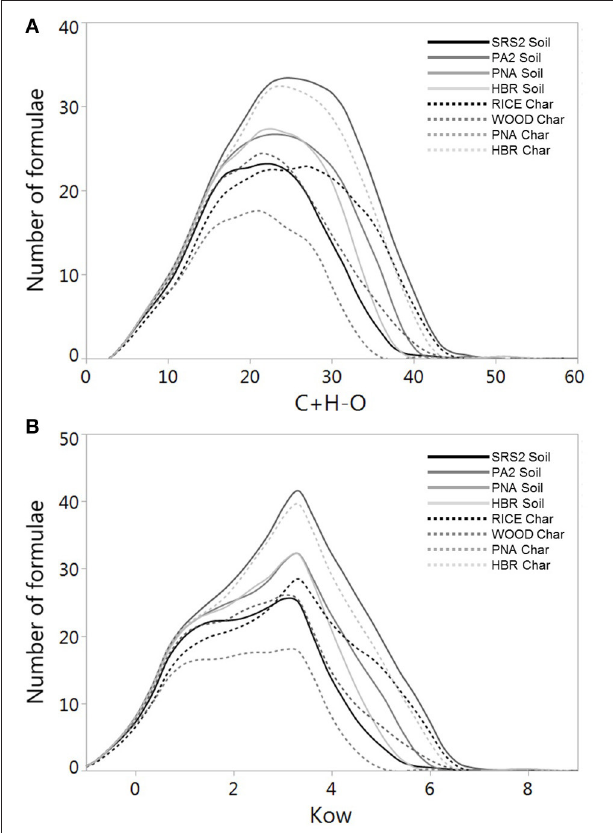
FIGURE 6 | Line plots showing the distribution of (A) C + H-O and (B) log K ow for DBC formulae identified in soil and char leachates.